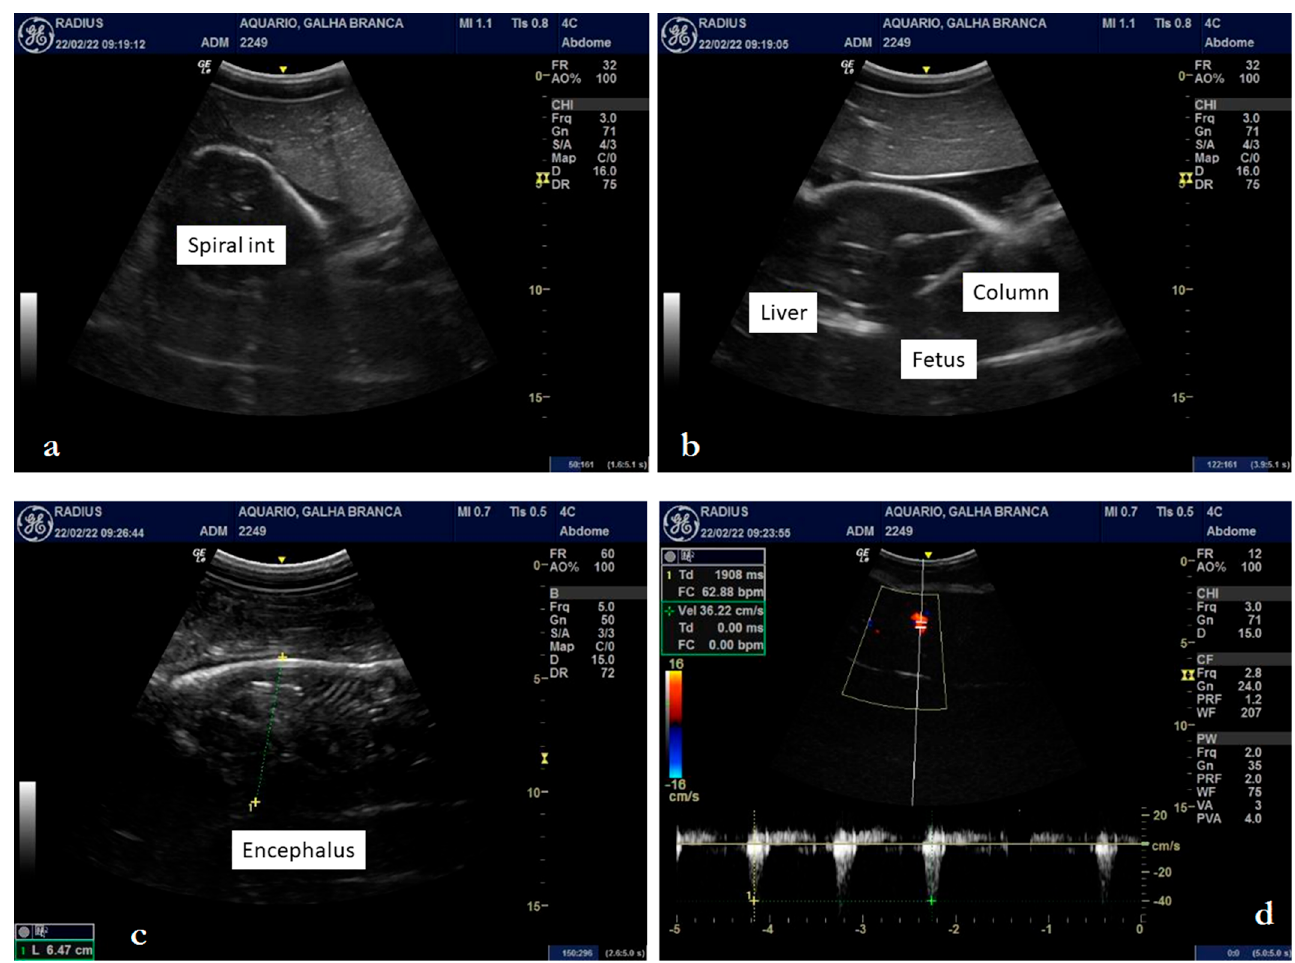
Figure 2. Ultrasonography of a female Triaenodon obesus (Rüppell, 1837) in late pregnancy: fetal orientation (brain/tail) and pectoral fins ( a ), hypoechogenic liver ( b ), eyes and gills ( c ), and heart with individualized chambers ( d ).